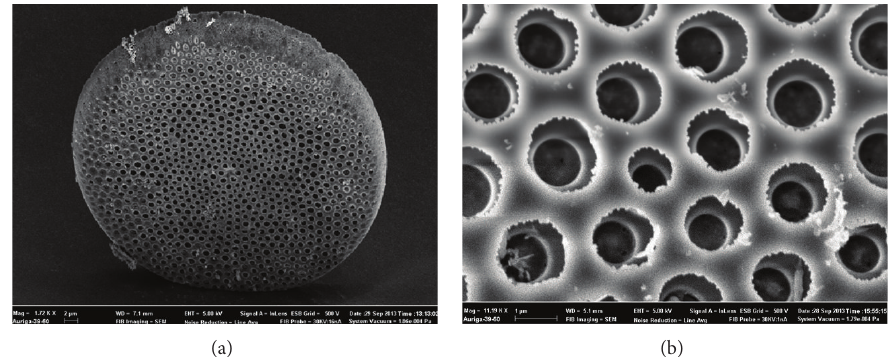
Figure 1: SEM images of the Coscinodiscus sp.: (a) SEM image of the whole Coscinodiscus sp. and (b) porous structure of the Coscinodiscus sp. frustule.